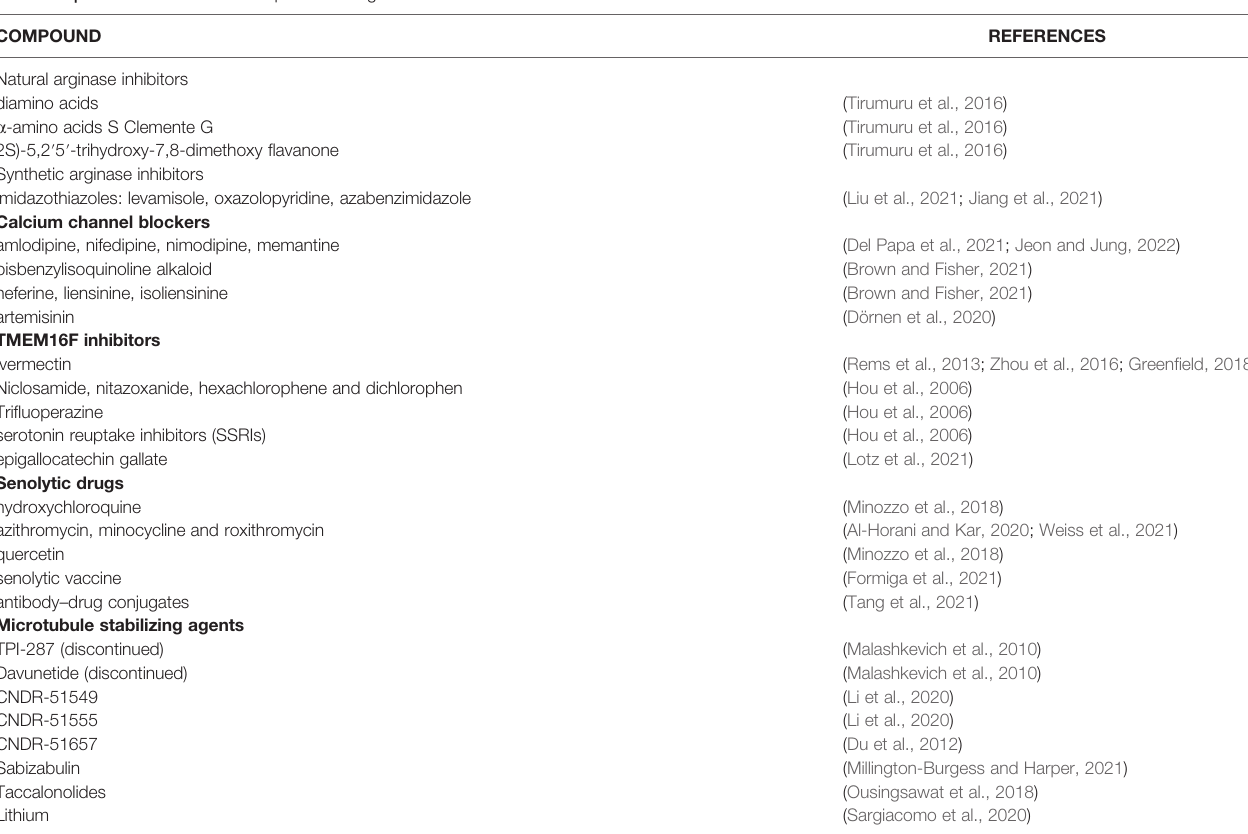
TABLE 3 | Potential anti-fusion therapeutic